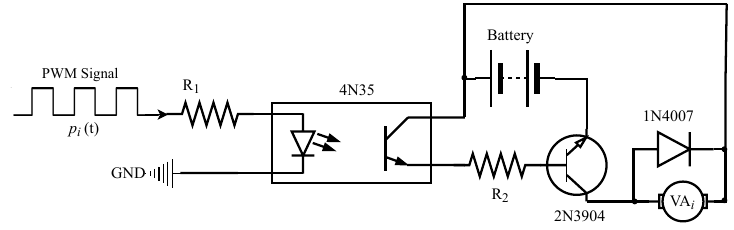
Figure 5. The driver circuit associated to each vibration actuator, VA i